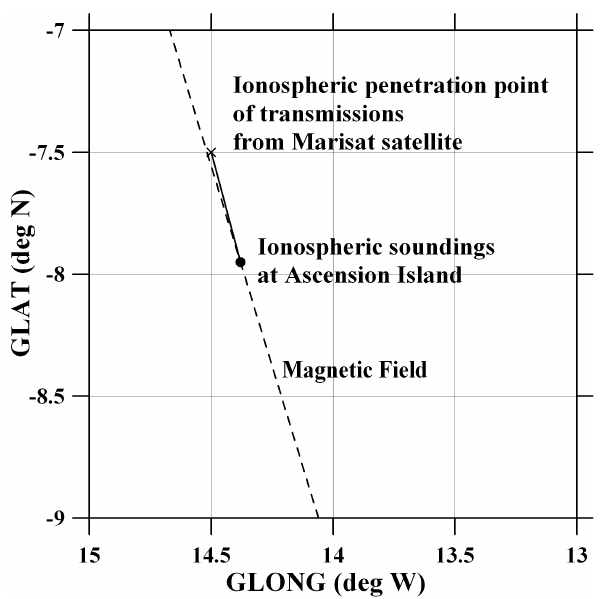
Fig. 1. Location of the measurements. Transmissions from the Marisat satellite are received along the ray path (solid line), aligned approximately along the magnetic field (dashed line) with the ef- fective ionospheric penetration point is shown as the X. Ionospheric soundings are made at the zenith at Ascension I. shown as the solid